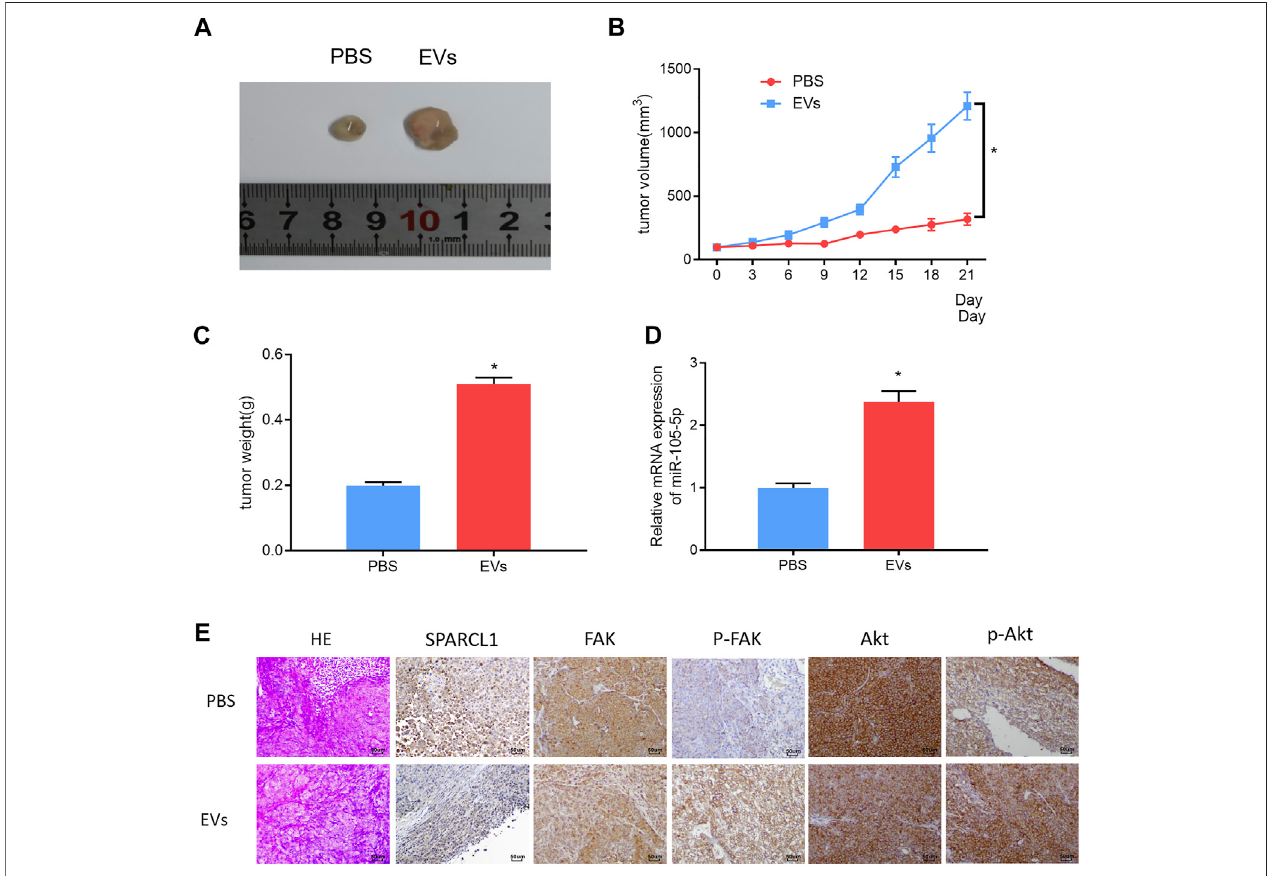
FIGURE 8 | Serum EV-derived miRNA-105-5p fosters ESCC cell growth in vivo by targeting SPARCL1 and regulating FAK/Akt signaling pathway. (A) Tumors of nude mice that were injected with PBS or serum EVs of ESCC patients; (B) Growth curves of tumors of nude mice; (C) Tumor weight of nude mice; (D) MiRNA-105-5p expression in tumors of nude mice; and (E) The protein expression of SPARCL1 and proteins related to FAK/Akt signaling pathway in tumors of nude mice (×200); * p < 0.05.